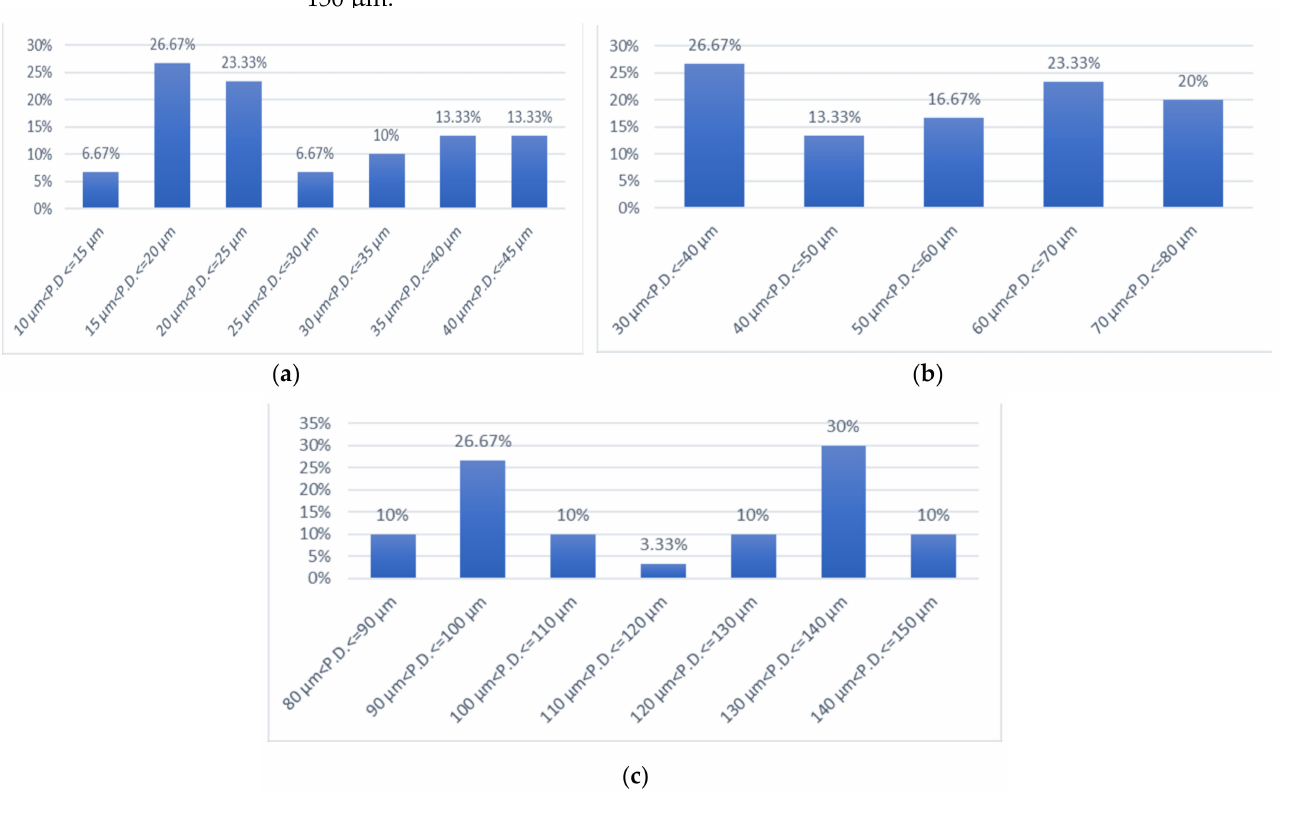
Figure 3. ( a ) Citric acid enamel demineralisation percentages after 3 min, at different penetration depths. ( b ) Citric acid enamel demineralisation percentages after 5 min, at different penetration depths. ( c ) Citric acid enamel demineralisation percentages after 7 min, at different penetration depths. P.D. means penetration